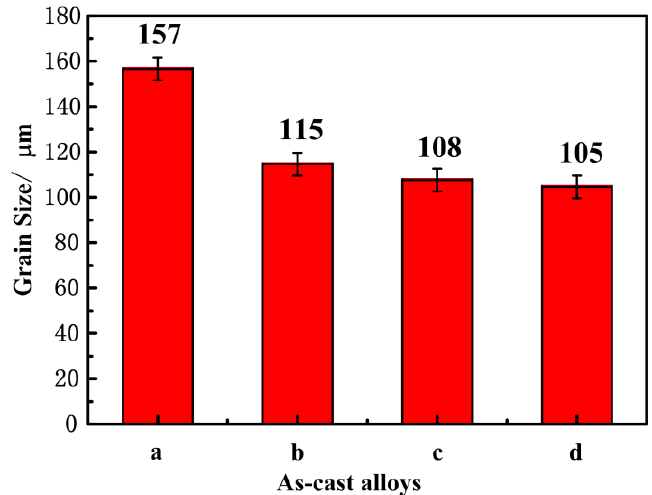
Figure 2. The change of the mean grain size of as-cast 7075 Al alloys without and with various contents of Sr addition: ( a ) 0 wt. % ; ( b ) 0.05 wt. % ; ( c ) 0.1 wt. % ; and ( d ) 0.2 wt. % Sr.